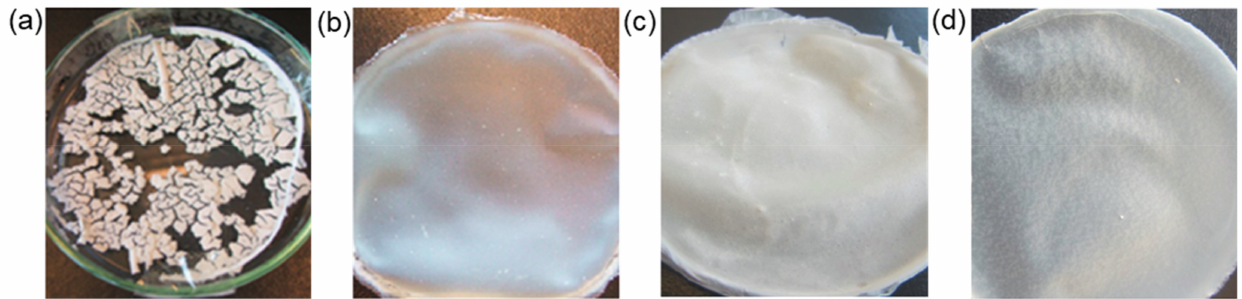
Figure 18. Images of PHB composite films: ( a ) filled with 5 wt% of neat CNC, ( b ) filled with 5 wt% of CNC with adsorbed surfactant, ( c ) filled with 20 wt% of CNC with adsorbed surfactant, and ( d ) filled with 20 wt% of CNC grafted with poly(lactic acid). Reproduced from [203] with permission of